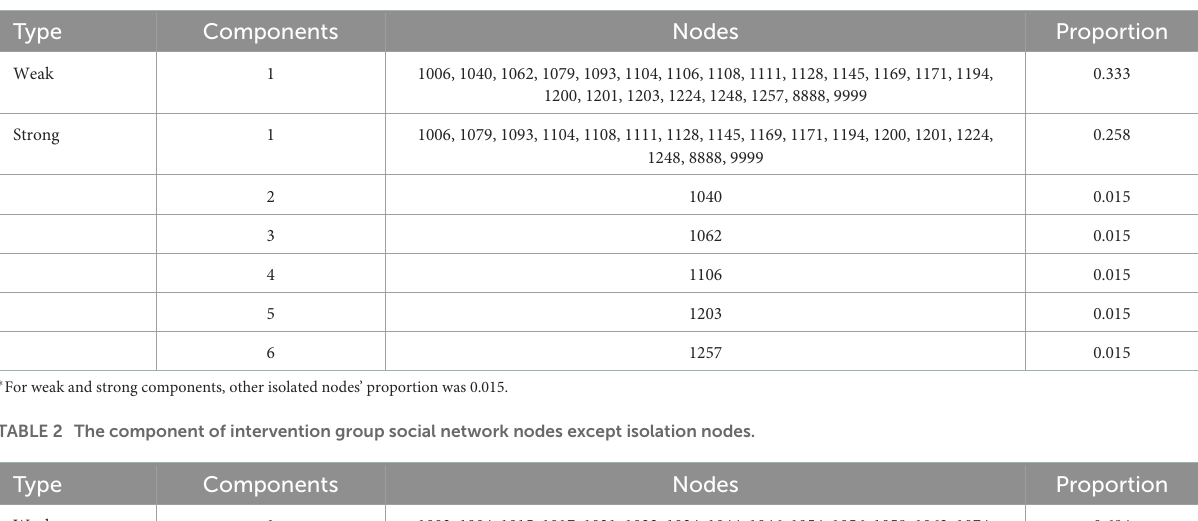
TABLE 1 The component of control group social network nodes except isolation nodes.